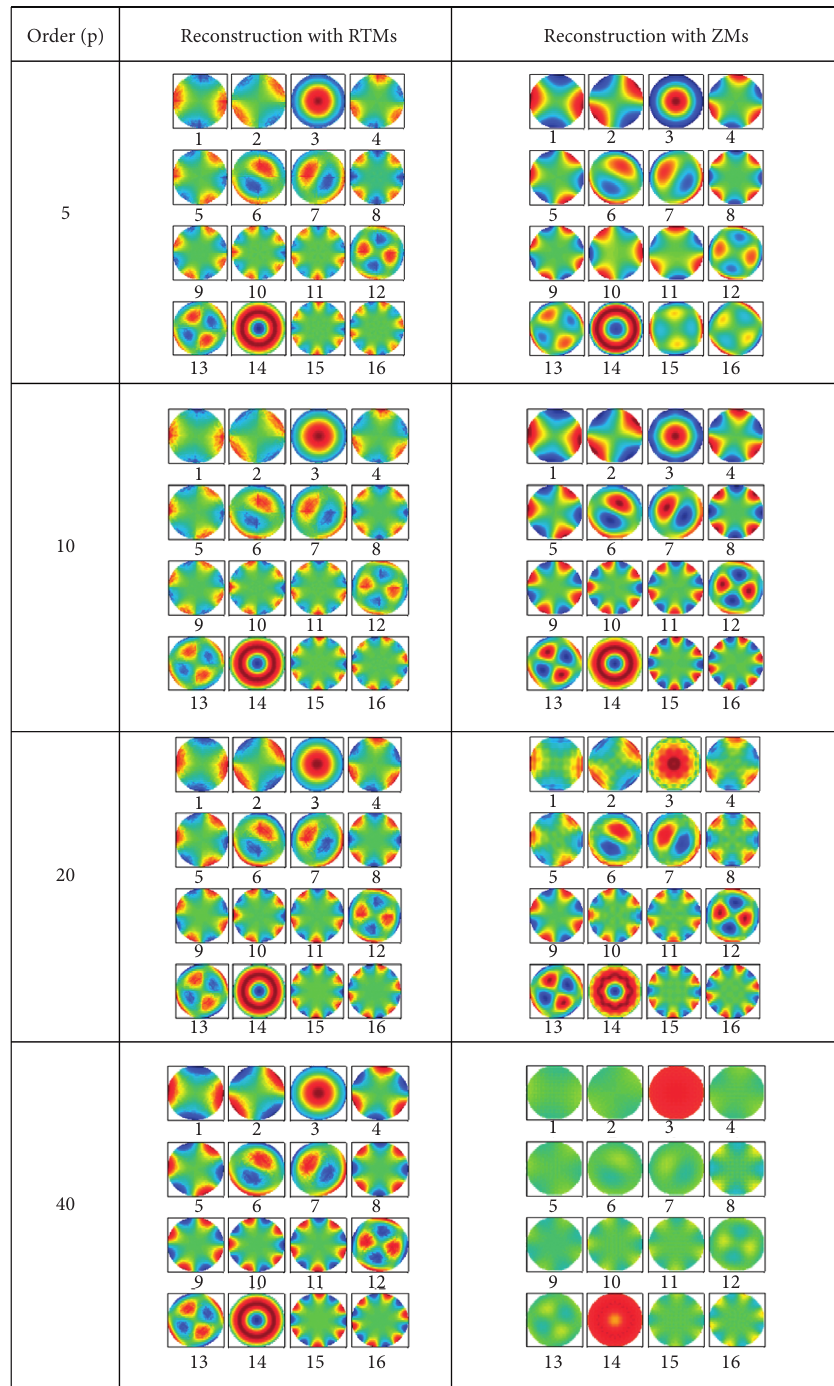
Figure 5: Comparison of the reconstruction of disc mode shapes for different